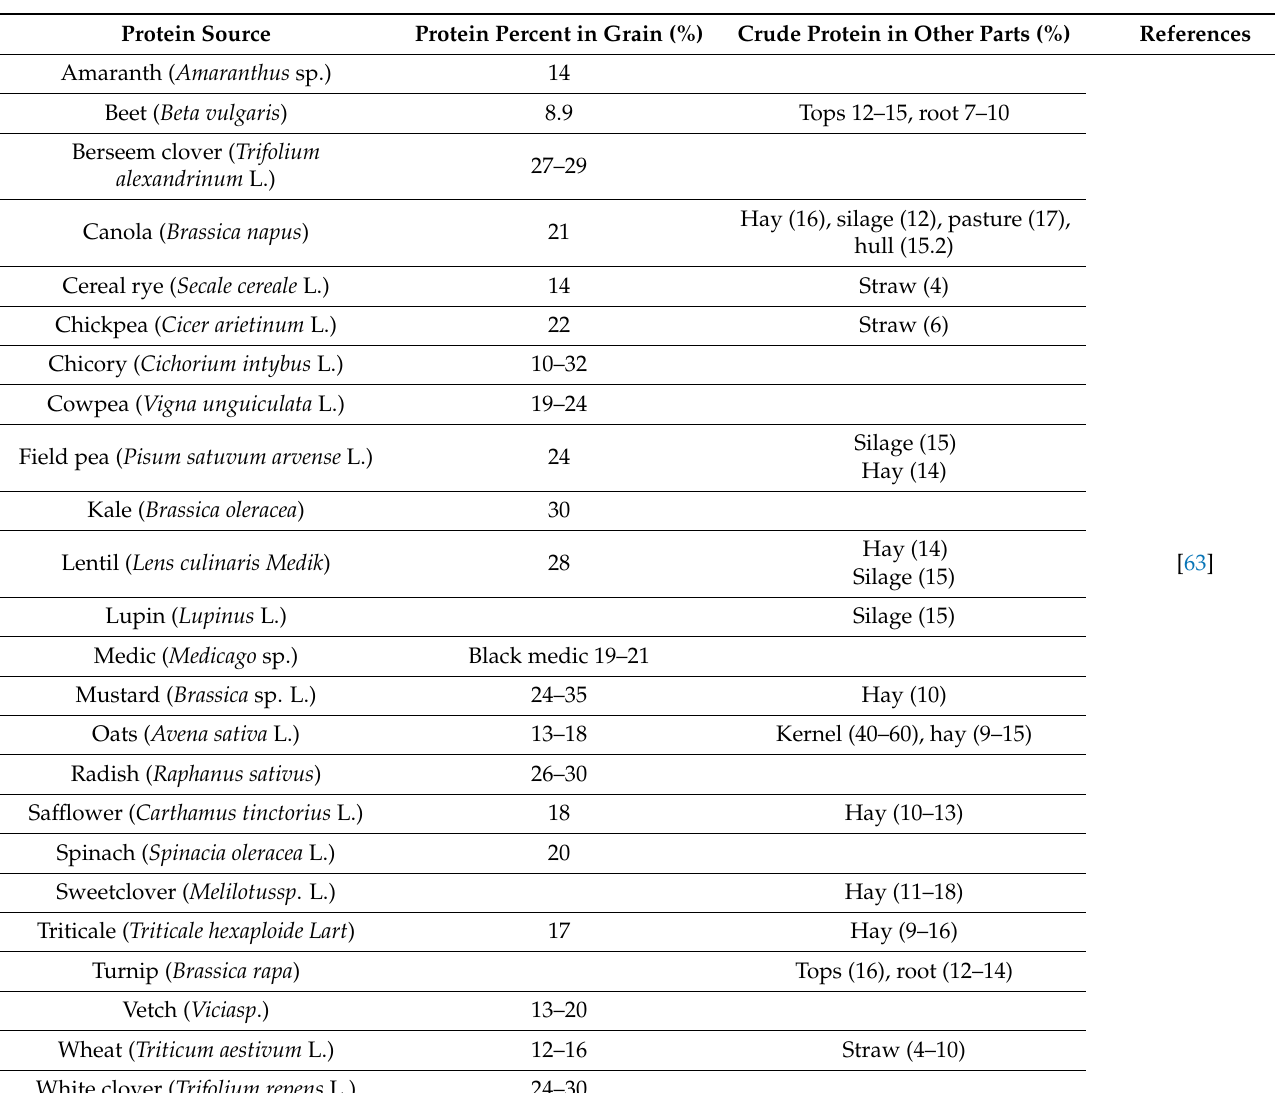
Table 3. Protein-rich cover crops in